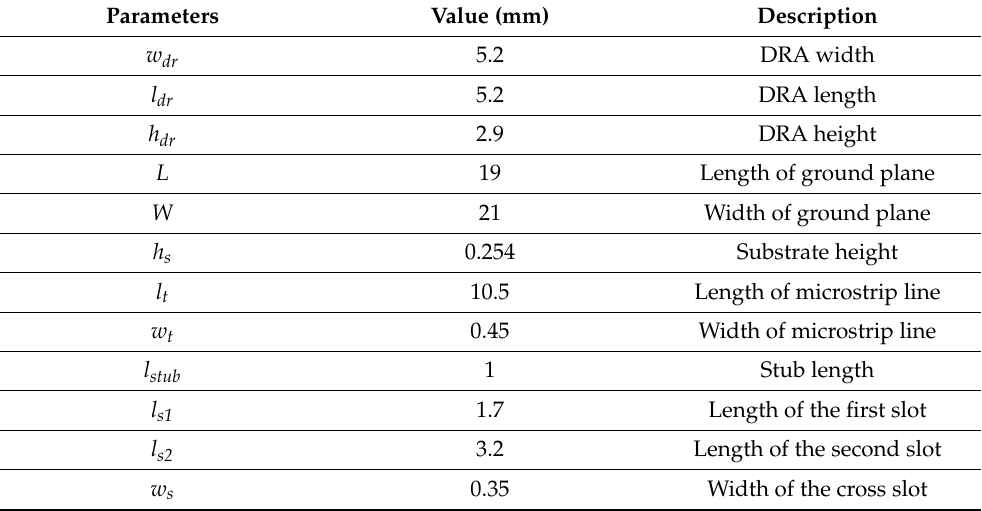
Table 2. Resonance frequencies of a number of TE modes supported by the